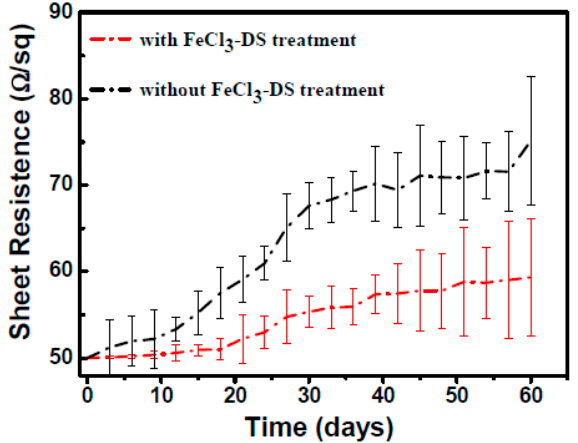
Figure 2. Sheet resistance variation of AgNW transparent conductive films (TCFs) after aging in air for pristine AgNW TCFs (black line) and FeCl 3 -DS treated ones (red line).